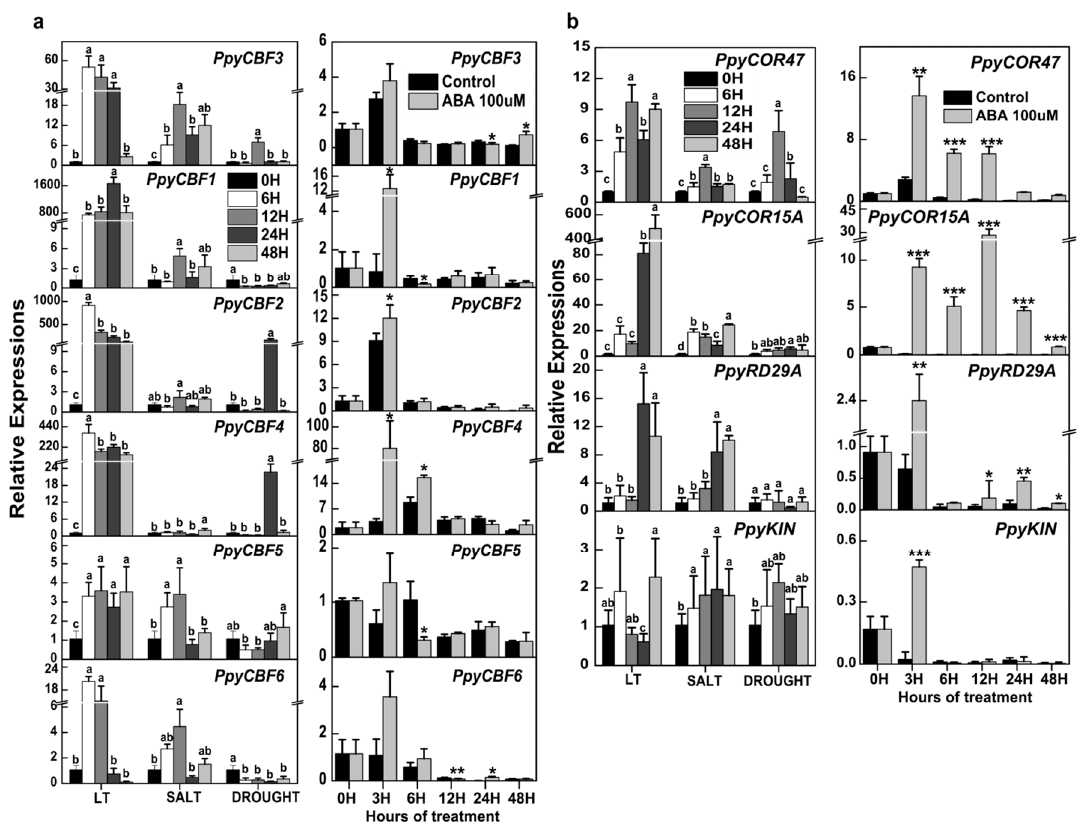
Figure 2. Relative expressions of PpyCBFs and PpyCORs during abiotic stresses and exogenous abscisic acid (ABA). ( a ) Expression analysis of PpyCBFs during abiotic stresses (cold, salt, and drought) and ABA according to their phylogenetic clades. ( b ) Expression analysis of PpyCOR47, 15A , RD29A , and KIN in the same samples for comparison study. Both relative expressions were normalized to PpyActin expression level. Error bars indicate standard errors from three biological replicates (* p < 0.05, ** p < 0.01, *** p < 0.001) while means with different letters had significant differences ( p < 0.05).